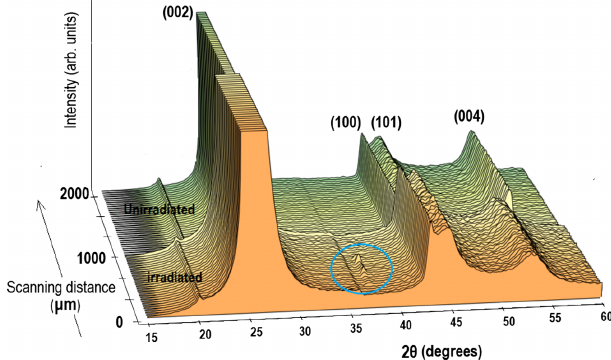
°C.FIG. 18. XRD map of irradiated POCO graphite around the (002) diffraction peak and the effect of 5 . 66 × 10 20 p = cm 2 fluence. (002) diffraction peak is truncated for